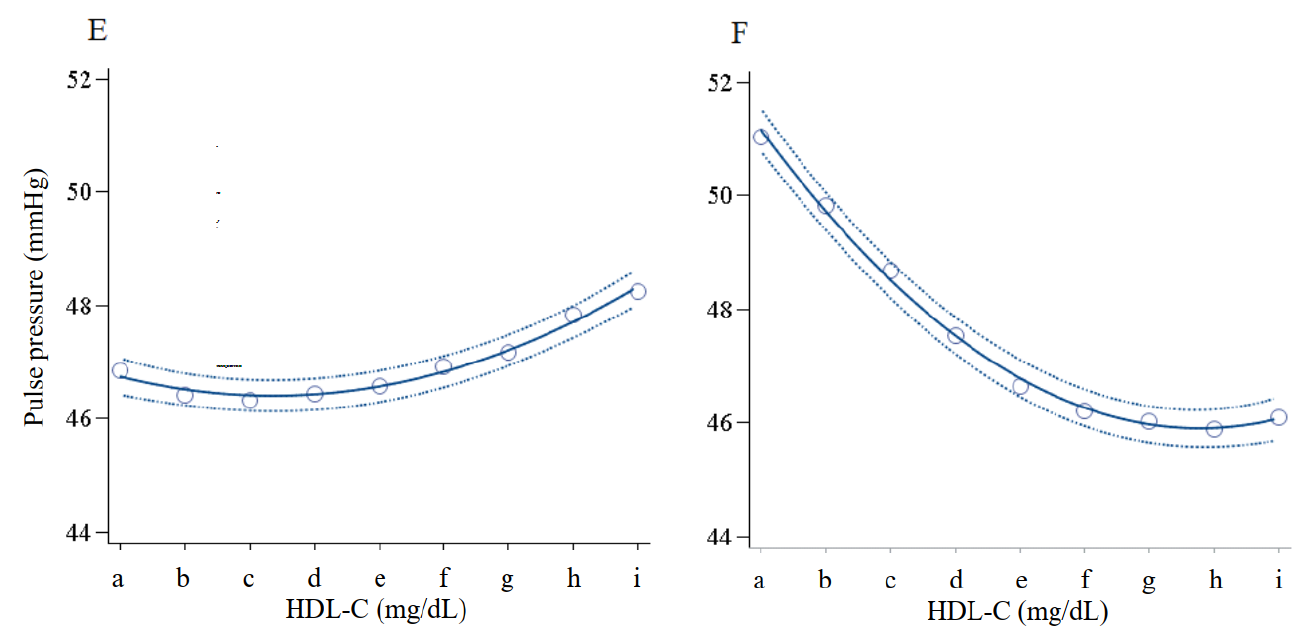
Figure 1. Blood pressure in men and women according to nine HDL-C concentration categories. With HDL-C concentrations of 20–39, 40–49, 50–59, 60–69, 70–79, 80–89, 90–99, 100–109, 110–119, and ≥120 mg/dL, n = 570,52, 193,722, 235,749, 171,612, 95,359, 45,195, 19,204, 7624, and 5152 for men and 6800, 44,379, 112,421, 160,350, 148,963, 99,424, 52,858, 22,886, and 14,402 for women, respectively. Open circle expresses mean of blood pressure in each HDL-C concentration category. Solid line and dashed line express quadratic regression curve and 95%CIs. a, 20–39; b, 40–49; c, 50–59; d, 60–69; e, 70–79; f, 80–89; g, 90–99; h, 100–109; i, ≥ 110 mg/dL. ( A ): Systolic blood pressure in men; ( B ): Systolic blood pressure in women; ( C ): Diastolic blood pressure in men; ( D ): Diastolic blood pressure in women; ( E ): Pulse pressure in men; ( F ): Pulse pressure in women. Table 2. Prevalence of HBP according to nine HDL-C concentration